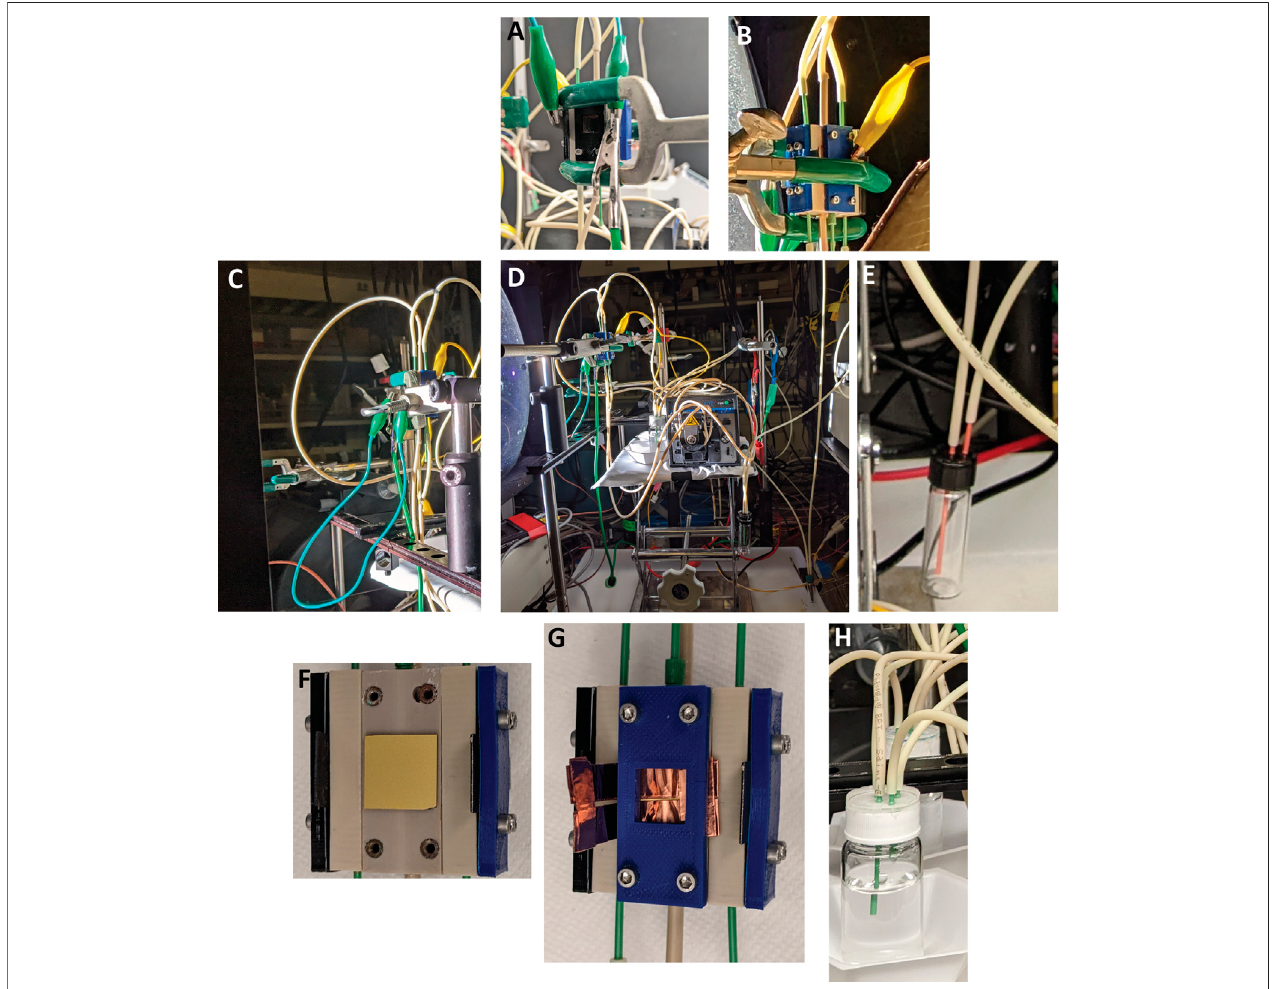
FIGURE14| Schematicof η F measurement. (A) Anodeconnectionstopotentiostat. (B) Photocathodeconnectiontopotentiostat. (C) Testingvesselclampedata distanceof1-sunfromthesolarsimulator. (D) Testvesselsetup:solarsimulatoronleft,electrolytepump,andreservoirsinthecenter,andGCtrapsleadingtotheGCon theright. (E) AliquidtrapplacedbetweentheelectrolytereservoirheadspaceandtheGCtopreventliquidfrombeingdrawnintotheGC. (F) Photocathode. (G) Electrical connection for photocathode and compression plate. (H) Two electrolyte reservoirs withcarrier gas inlets and outlets connected to the GC traps, in addition to the electrolyte circulation inlet and